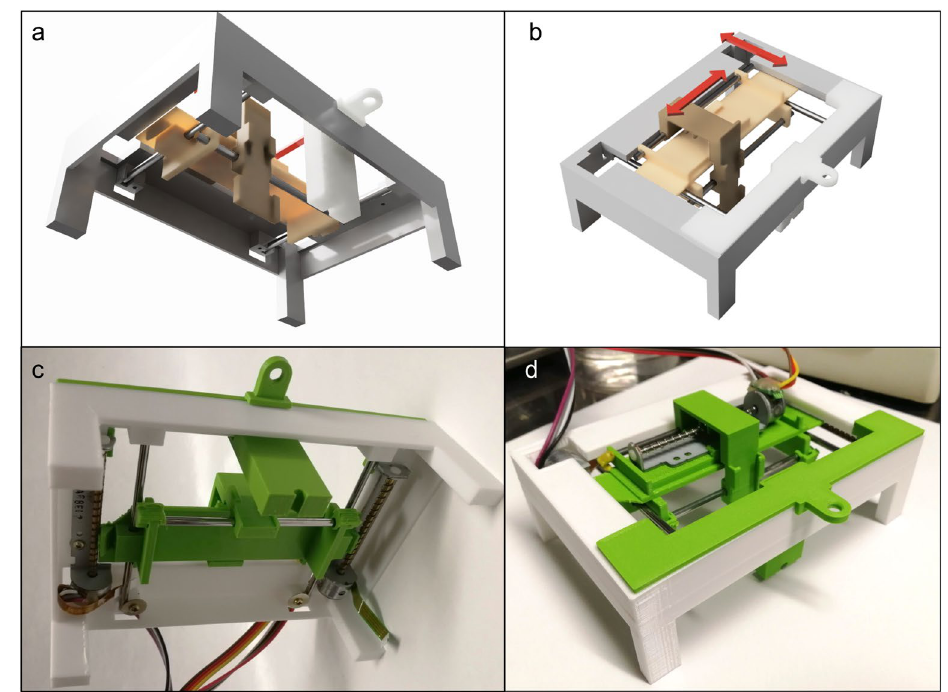
Figure 13. ( a , b ) Renders of the 3D printed files. ( c , d ): pictures of the micropipette positioning system and micropipette holder.